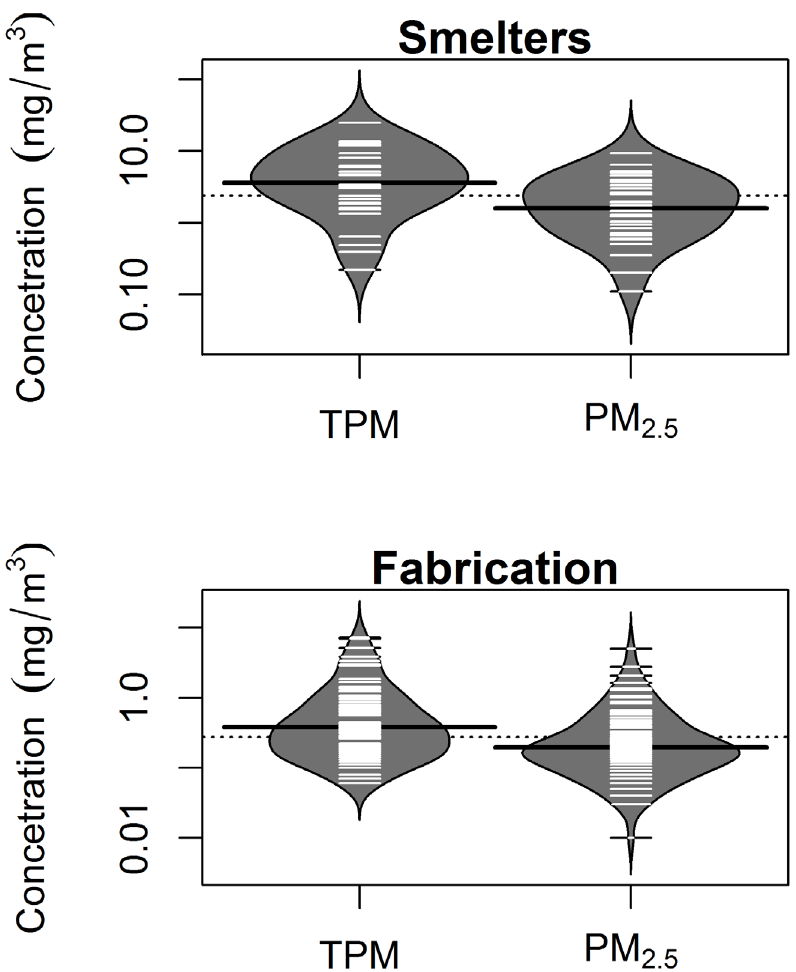
Fig 3. Beanplots of the distributions of TPM and PM 2.5 concentrations for distinct exposure groups based on an aluminum industry JEM, for two different facility types: smelters and fabrication. The dark horizontal line represents the mean value for each distribution, while each white beanline represents a point for each distinct exposure group.